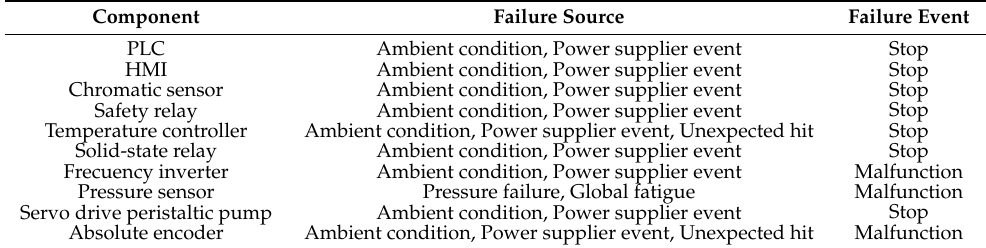
Table 2. Electronic components in the studied MSTM with failure source and event.